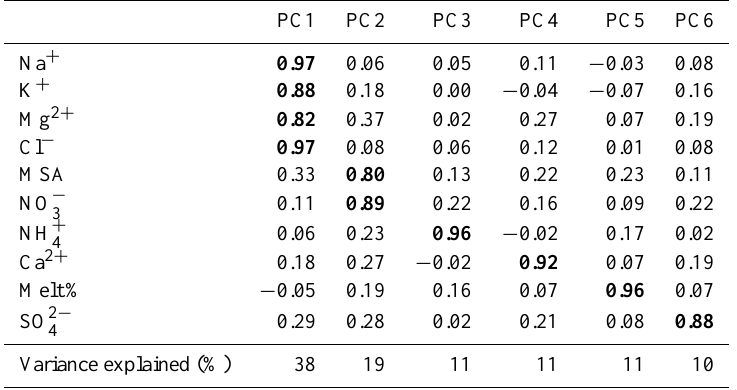
Table 2. Results of the principal component analysis (PCA) after VARIMAX rotation. Time period: 1222–1859; data: 10-year averages; MSA: CH 3 SO − ; melt%: melt percent. Values >0.8 marked in bold. 3 PC1